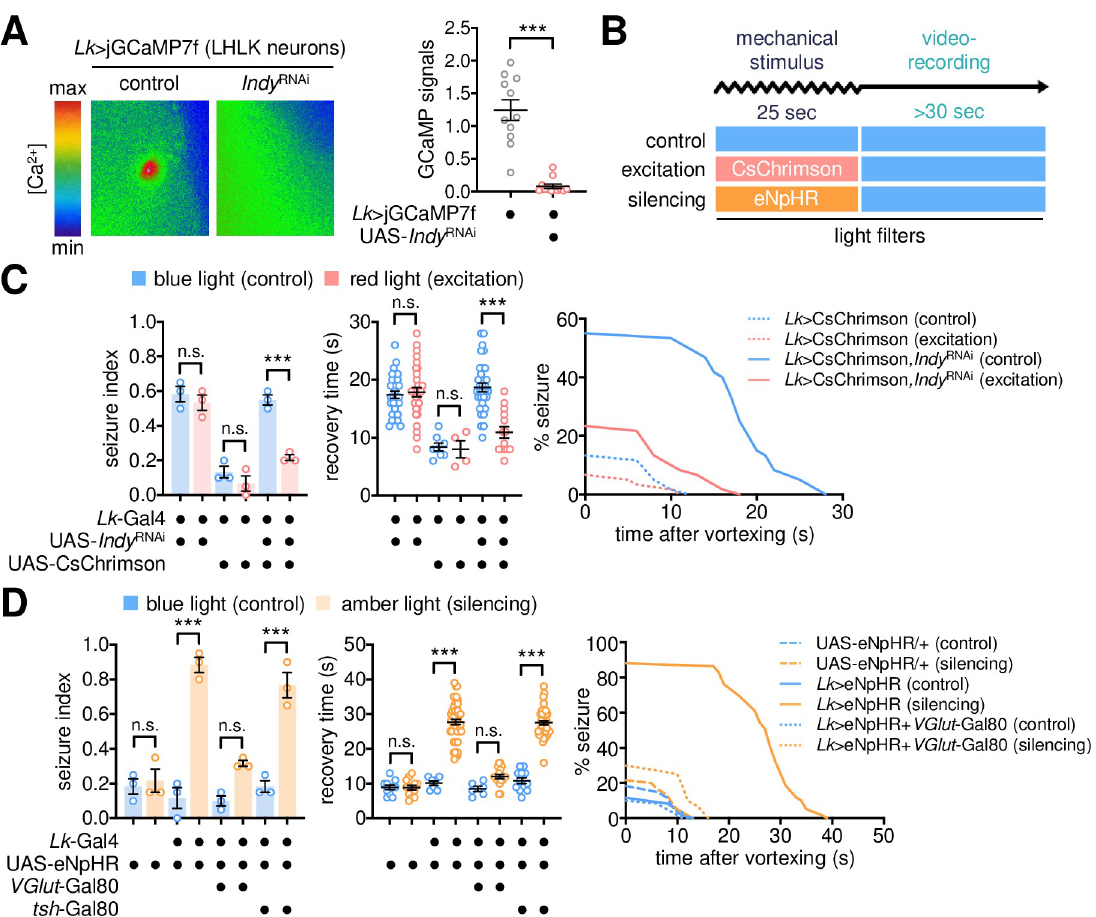
Fig 6. LK neuron activity gates the behavioral output from seizure initiation. (A) INDY depletion reduces intracellular Ca 2+ levels in LHLK neurons. The codon-optimized calcium sensor, jGCaMP7f, was co-expressed with Indy RNAi in LK neurons. The fluorescence signal in LHLK neurons was analyzed as described in Fig 5A. Data represent means ± SEM (n = 11–12). ��� P < 0.001, as determined by Mann- Whitney test. (B) Experimental design for optogenetic manipulations of neural activity during the assessment of BSS. (C) Optogenetic excitation of LK neurons substantially suppresses BSS in INDY-depleted flies. Transgenic flies were crossed and kept in constant darkness. The mechanical stimulus was given under blue light (no excitation) or red light (excitation by CsChrimson), and BSS phenotypes were then assessed under blue light. Quantitative analyses of BSS in individual flies were performed as described in Fig 1. Data represent means ± SEM (seizure index, n = 56–60 flies in 3 independent experiments; recovery time, n = 4–33 flies). n.s., not significant; ��� P < 0.001, as determined by two-way ANOVA with Holm-Sidak’s multiple comparisons test. (D) Optogenetic silencing of glutamatergic LK neurons induces BSS in a wild-type background. The mechanical stimulus was given under blue light (no silencing) or amber light (silencing by eNpHR). Data represent means ± SEM (seizure index, n = 59–60 flies in 3 independent experiments; recovery time, n = 6–52 flies). n.s., not significant; ��� P < 0.001, as determined by two-way ANOVA with Holm-Sidak’s multiple comparisons